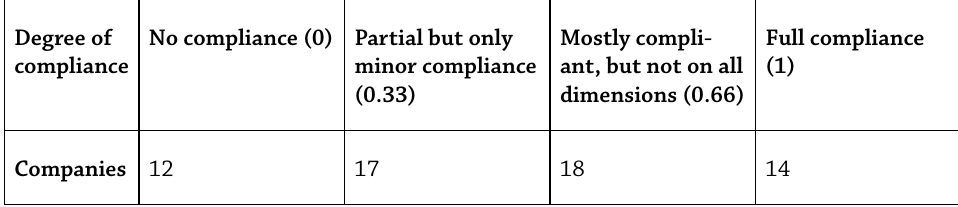
Table 11: Overall